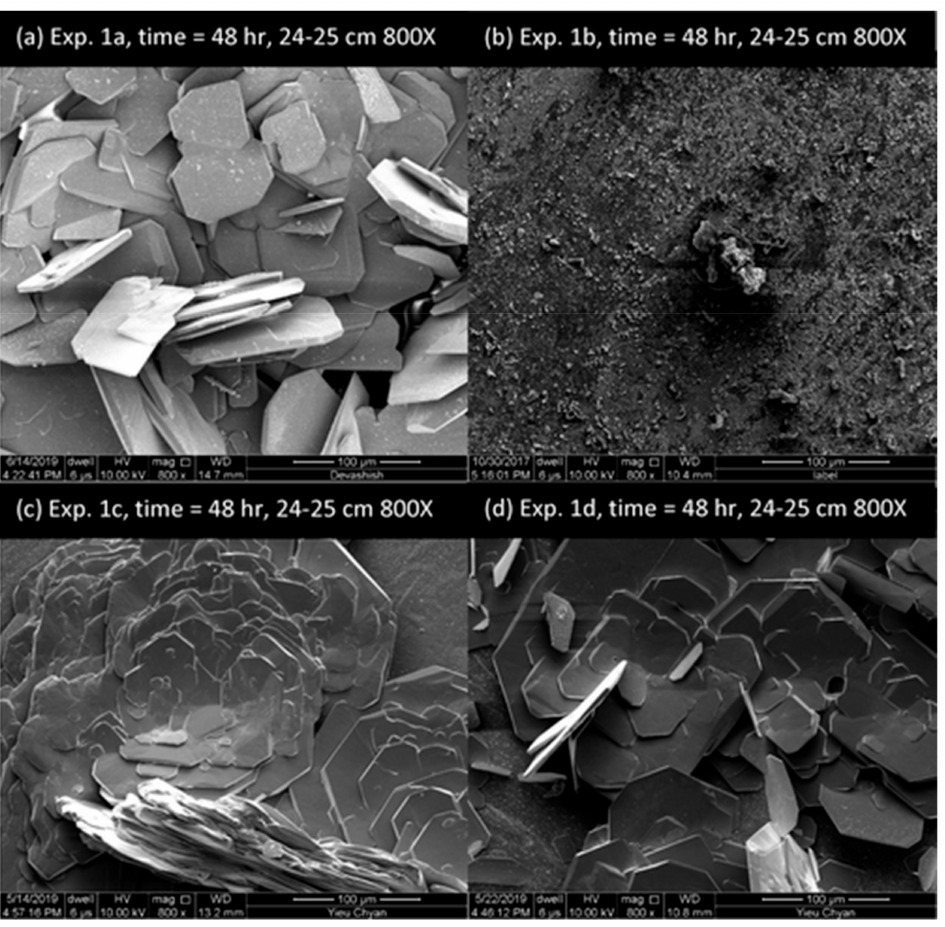
Figure 1. SEM image of stainless-steel tubing in experiments: ( a ) without the presence of inhibitors, ( b ) tubing wall with no deposited barite crystal, ( c ) presence of PPCA, and ( d ) SPCA